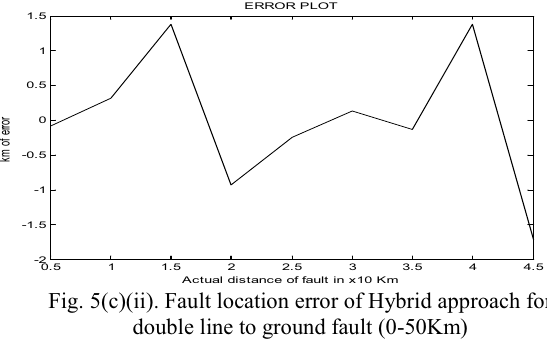
Fig. 5(c)(ii). Fault location error of Hybrid approach for double line to ground fault (0-50Km)